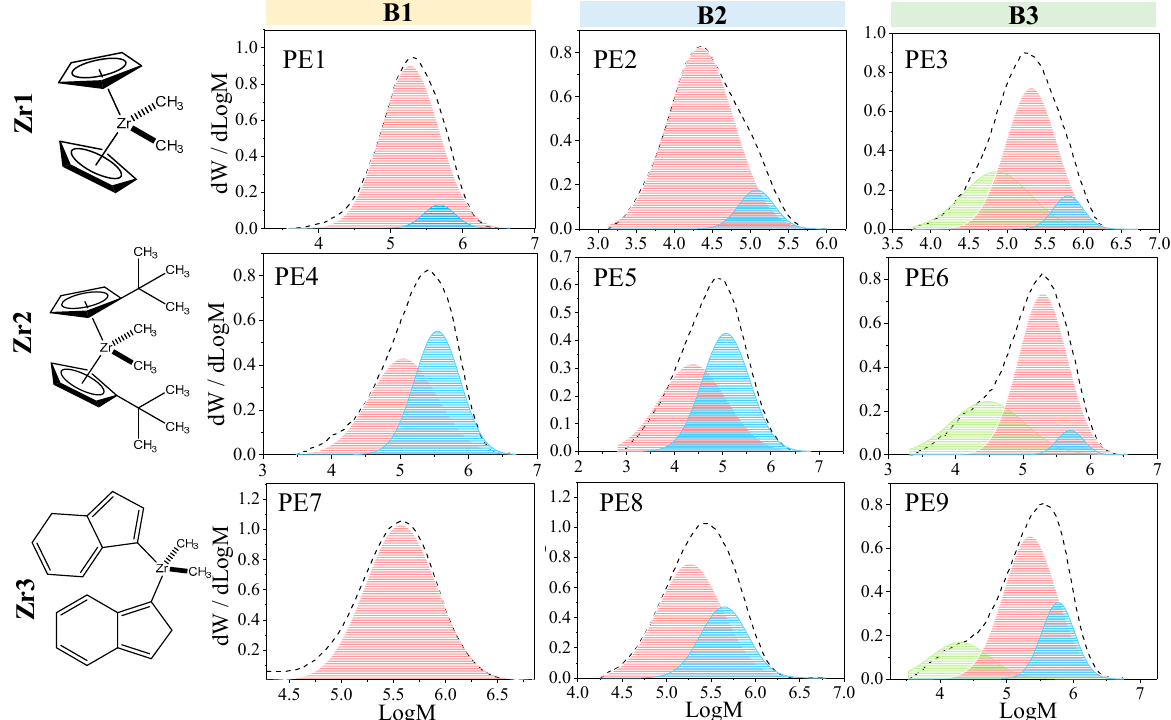
Figure 3. Deconvoluted molecular weight distributions of the synthesized PE using the different catalytic systems.